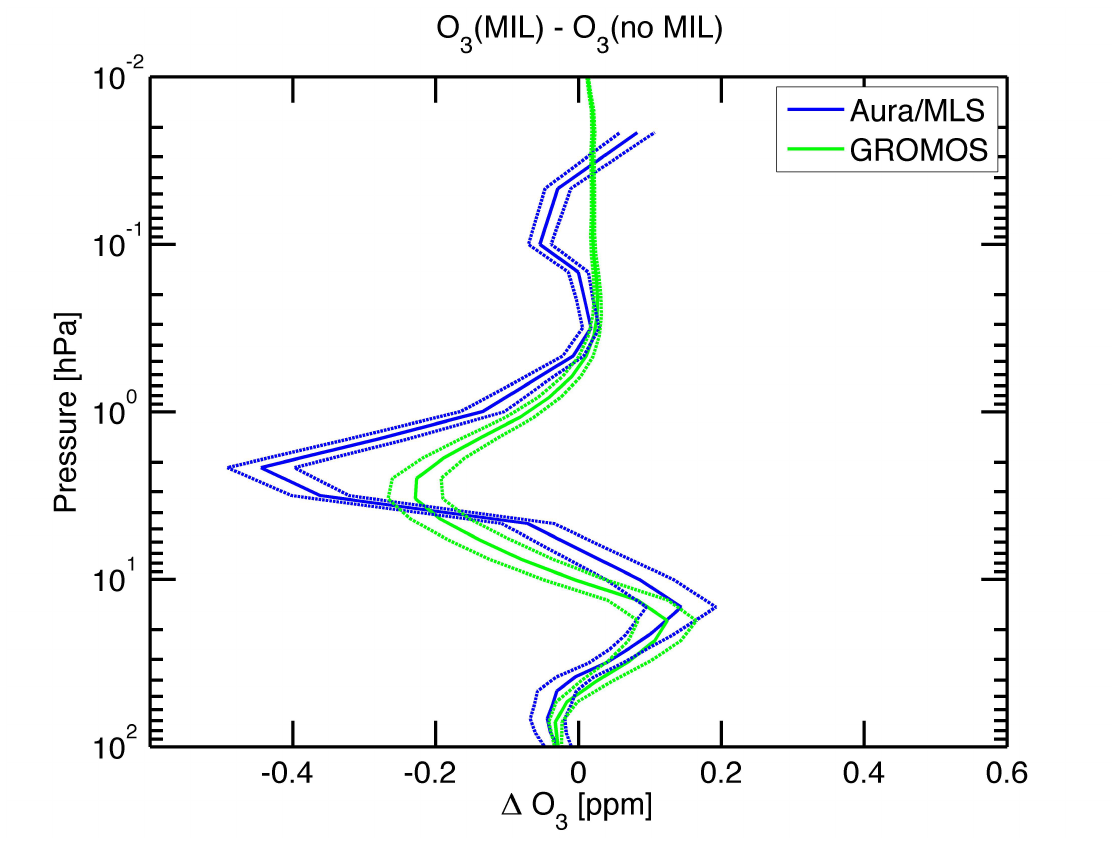
Figure 6. Difference profiles “MIL” minus “no MIL” for ozone observations by the ground-based ozone radiometer GROMOS (green) and by the satellite experiment Aura/MLS (blue) above Bern during winter. Dashed lines show the error of the